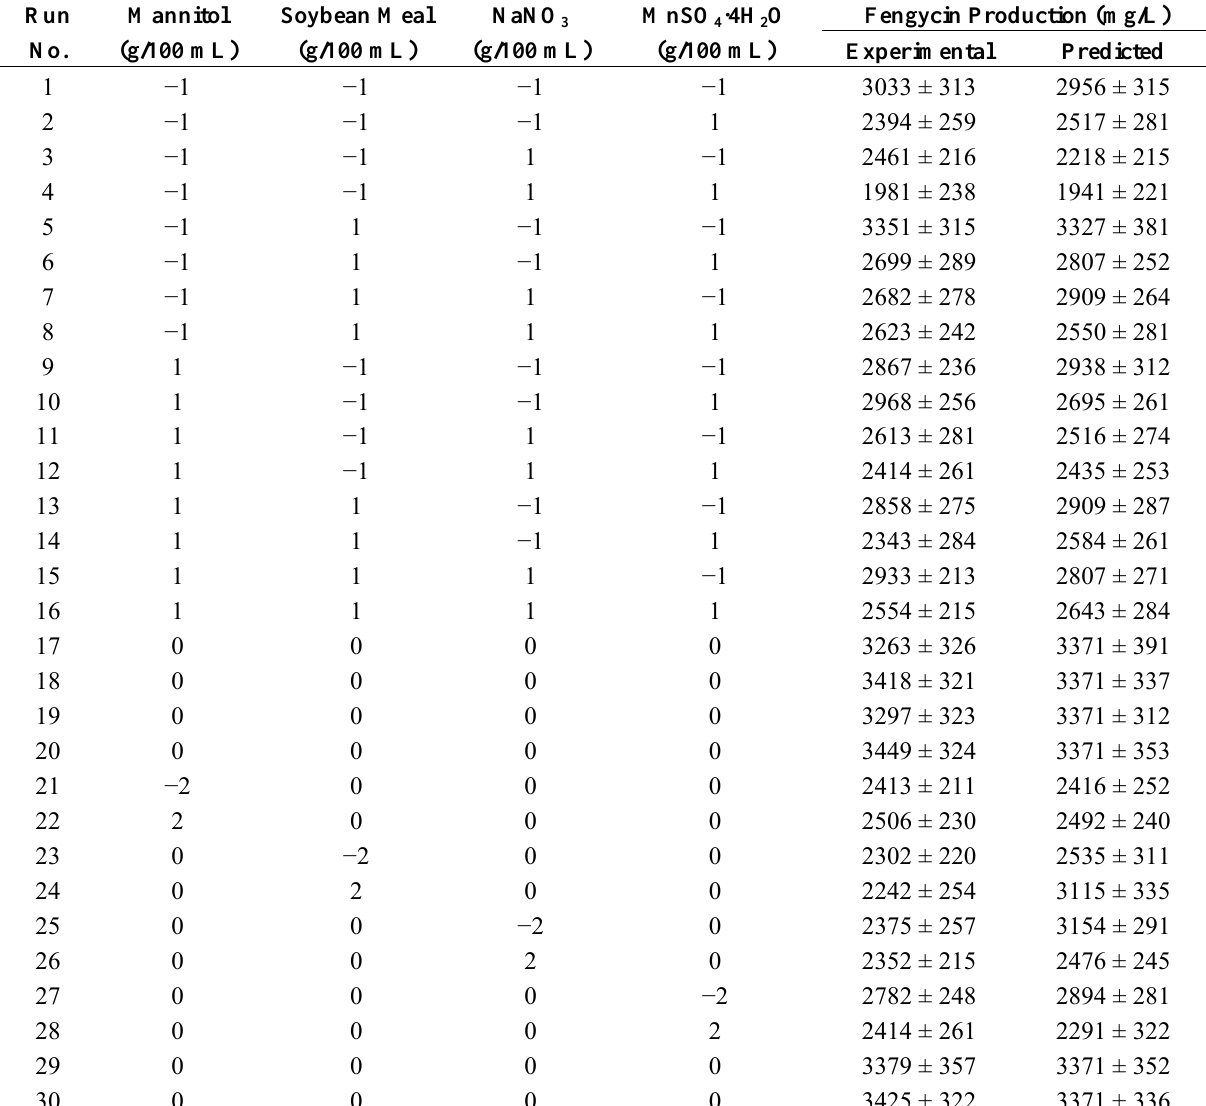
Table 5. Experimental design and results of central composite design (CCD) of response surface method to optimize fengycin production ( n =